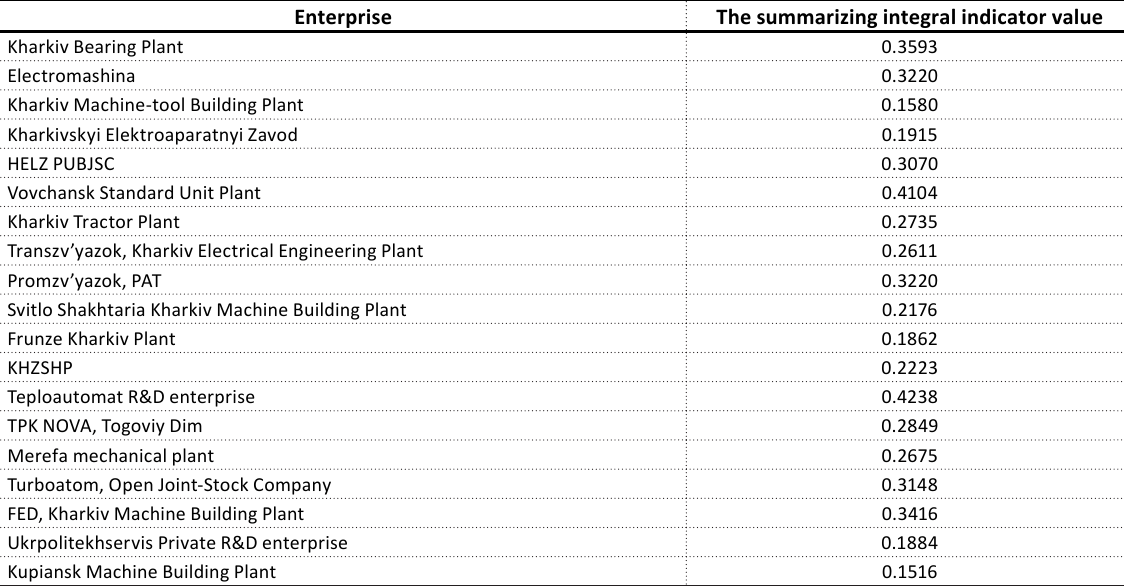
Table 7. Predictive value of the summarizing integral indicator of investment and innovation activity of enterprises for 2019 using the multilevel perceptron model